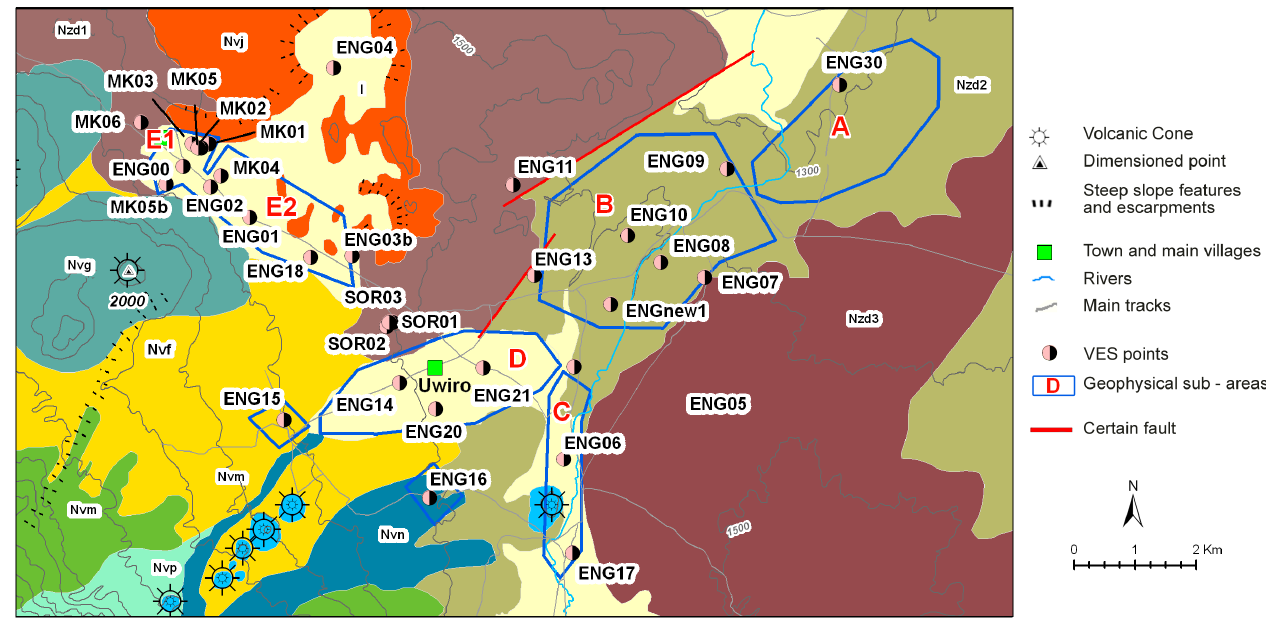
Fig. 3. Location map of the electrical soundings in the Ngarenanyuki ward. Sub-areas defined as explained in Table 3. For the geological legend, see Fig.